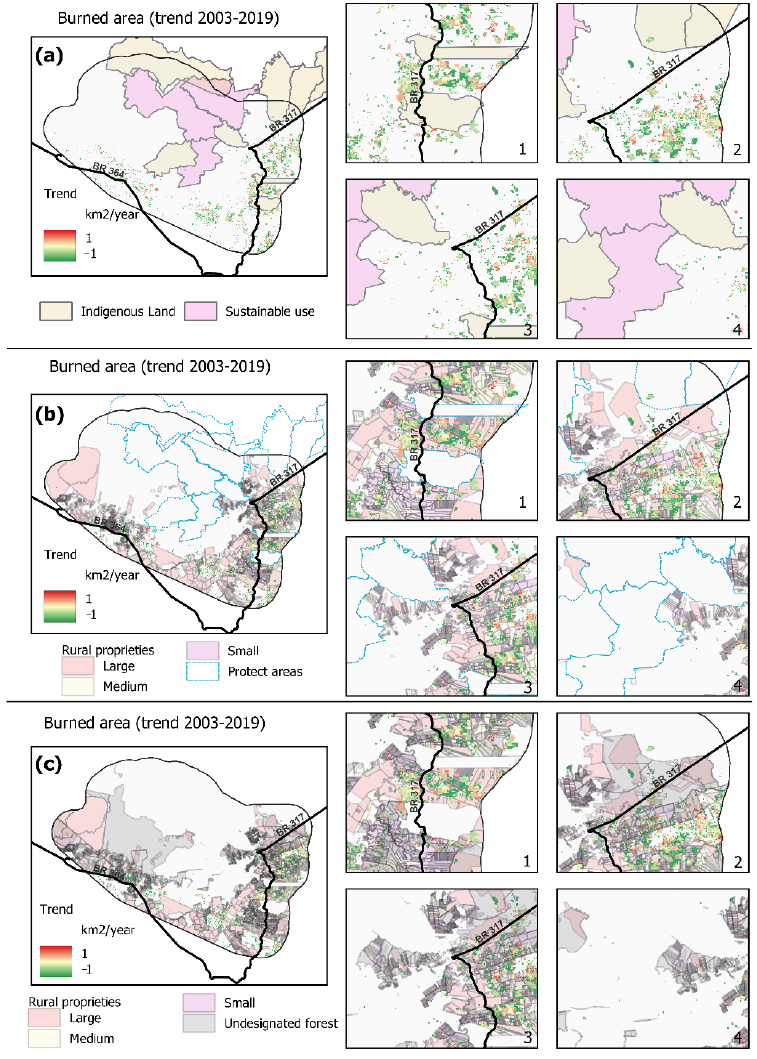
Figure 7. Spatial trends of the burned area between 2003 and 2019. Negative values (close to green) represent a decrease in the trend, while positive values (close to red) represent an increase in the trend. The spatial trends are shown overlapping ( a ) protected areas, ( b ) rural “properties” ( c ) rural “properties” and undesignated public forests.